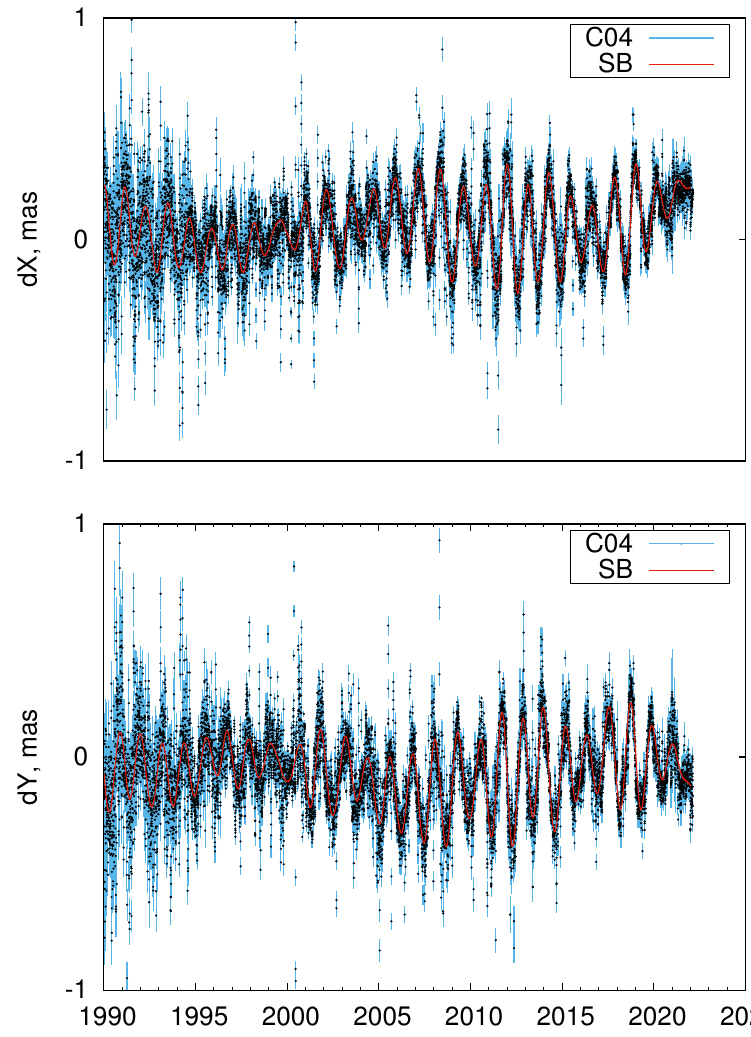
Figure 2. SB (red line) and IERS C04 (black points with blue error bars) CPO series. The two FCN models, ZM3 and SB, are compared in Figure 3. One can see that two models are very close except for the period before 2002 (start of the R1 and R4 IVS observing programs [10]) and the very end of the series. One of the main reasons between the discrepancies of the SB and ZM3 FCN models are the differences between the IERS C04 and IVS CPO series shown in Figure 4. For this comparison, C04 CPO values were linearly interpolated at the IVS CPO epochs. The differences between the IVS and IERS CPO series were discussed in more detail in